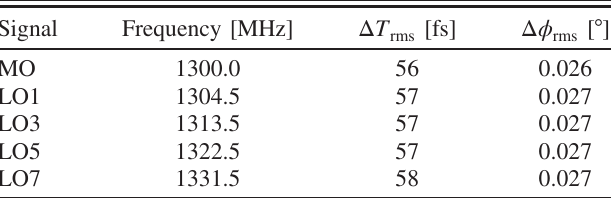
TABLE IV. rms jitter and phase of MO and LO within the interval of offset frequency from 10 Hz to 1